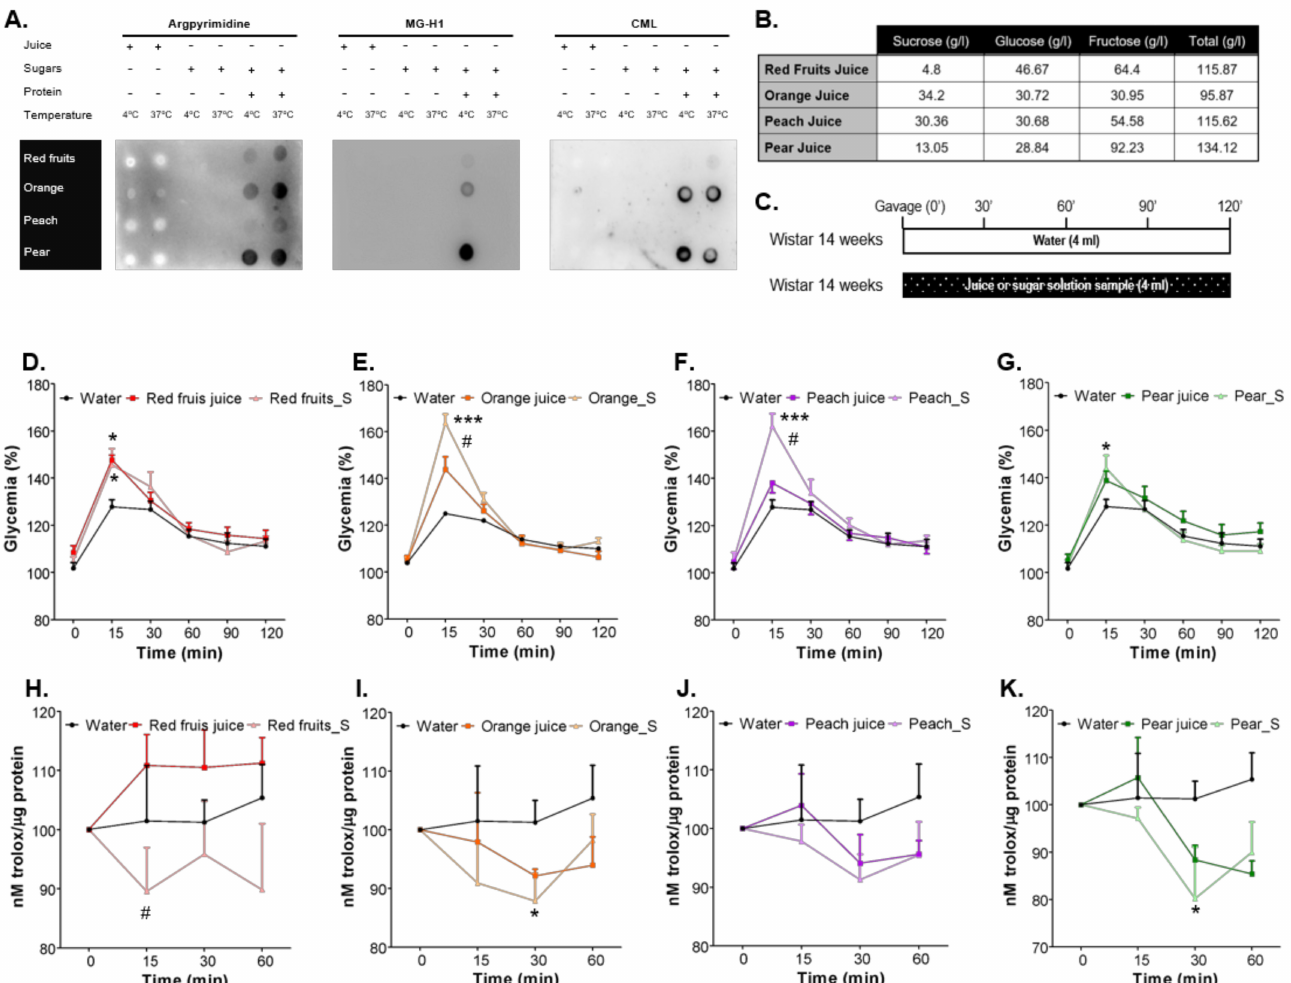
Figure 1. The AGEs CML, MG-H1 and Argpyrimidine were detected by dot blot ( A ) in fruit juices and sugary solutions with the same sugars profile ( B ) in the presence or absence of BSA, at 4 ◦ C or 37 ◦ C. In other to determine the postprandial glycaemia, an OGTT was performed ( C ) and glycaemia and total antioxidant capacity of erythrocytes was determined after intake of 4 mL of red fruits ( D , H ), orange ( E , I ), peach ( F , J ) and pear ( G , K ) fruit juices or a sugary solution with the equivalent sugars profile. * different from Water; # different from the fruit juice. 1 symbol, p < 0.05; 3 symbols, p <